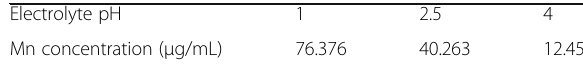
Table 1 Concentration of Mn ions in Na + /Zn 2+ mixed-ion elec- trolyte after exposure to Na 4 Mn 9 O 18 for 48 h Electrolyte